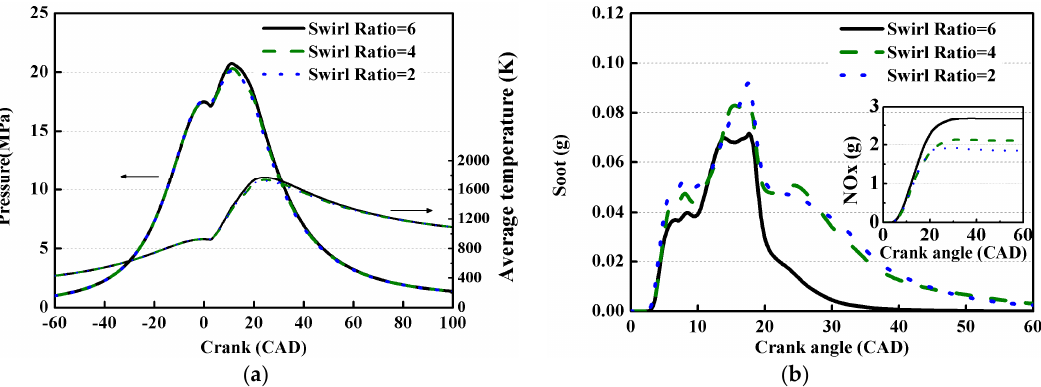
Figure 13. Combustion and emission performances of HFO at different swirl ratios. ( a ) Pressure and average temperature; ( b ) Soot and NO x .